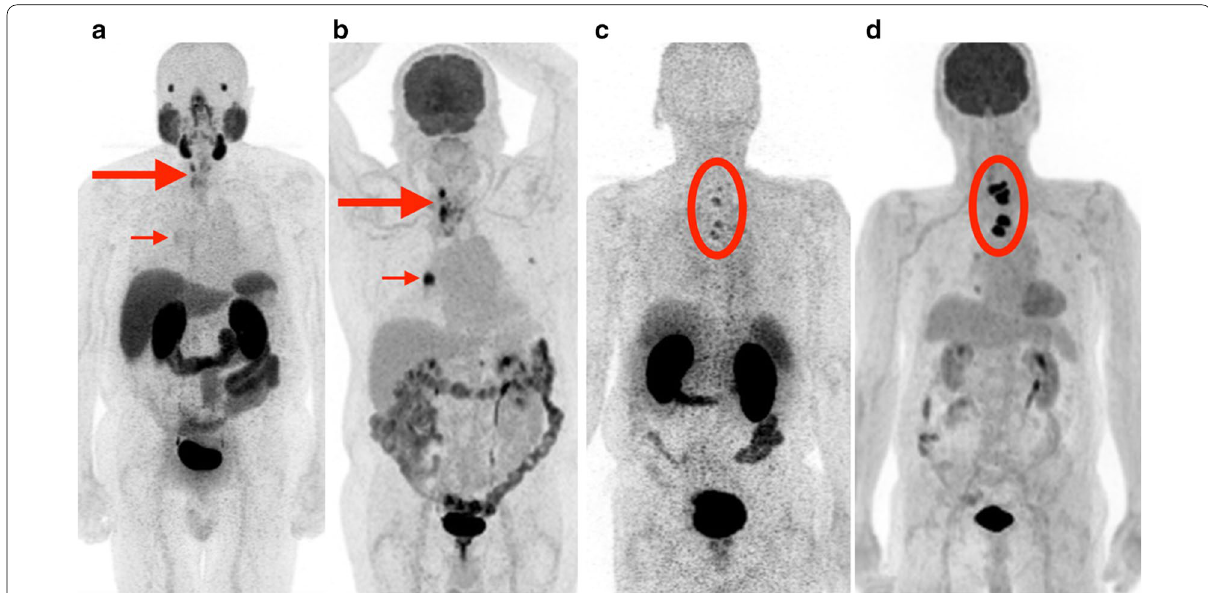
Fig. 4 Patients with metastatic thyroid cancer with greater FDG uptake than PSMA uptake: examples. a , b [ 68 Ga]Ga‑PSMA‑11 PET MIP ( a ) and 2‑[ 18 F] FDG PET MIP ( b ) in a patient (Patient 4) with anaplastic thyroid carcinoma. Thyroid bed recurrence (large arrows) and right hilar nodal metastasis (small arrows) are more avid on FDG (median SUVmax 14.3) than PSMA (median SUVmax 3.3). c , d [ 68 Ga]Ga‑PSMA‑11 PET MIP ( c ) and 2‑[ 18 F]FDG PET MIP ( d ) in a patient (Patient 1) with papillary thyroid carcinoma. Multiple lower cervical and upper thoracic vertebral body metastases (circled) are more avid on FDG (median SUVmax 21.1) than on PSMA (median SUVmax